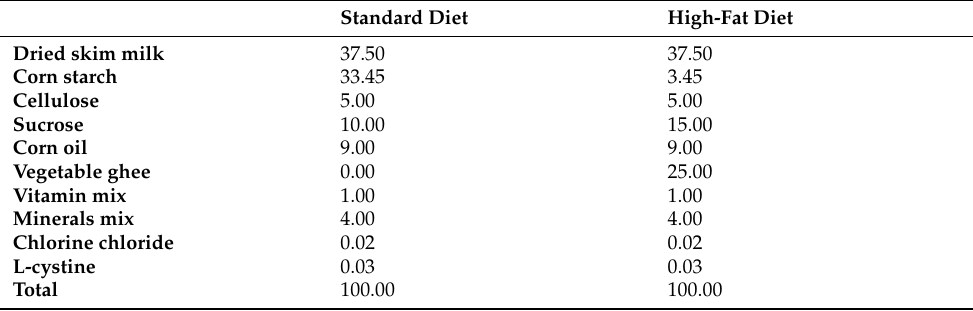
Table 2. Standard and high-fat diet composition (%) “based on the dry weight”. Standard